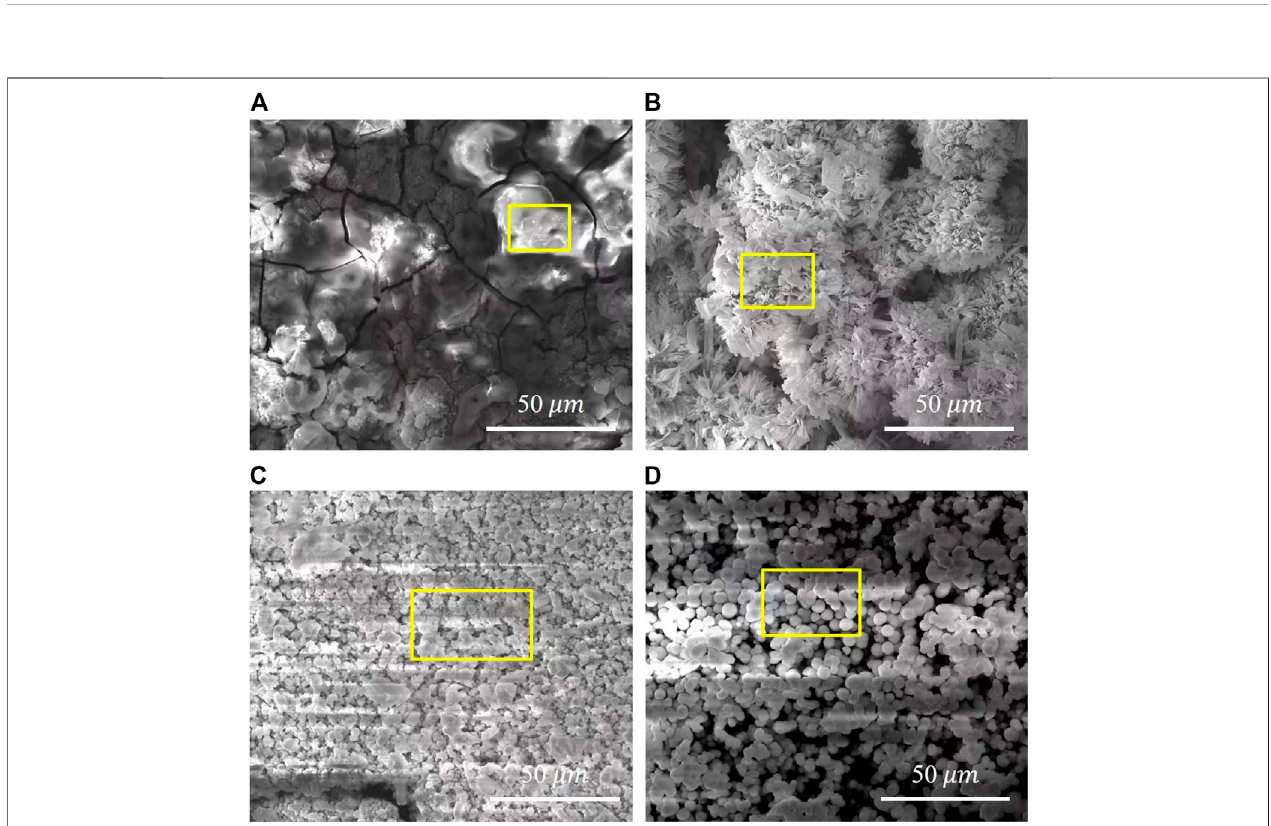
FIGURE 9 | Surface morphology of samples after electrochemical measurement: (A) bare AZ91D, (B) pH 5.5-treated, (C) pH 8.5-treated, (D) pH 11.5-treated.